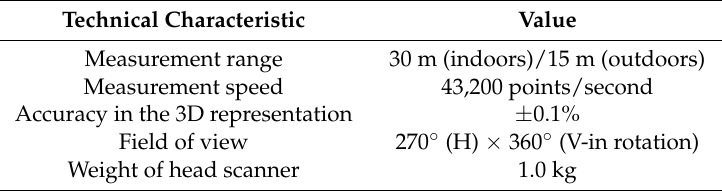
Figure 6. View of the Zeb-Revo during acquisition. Table 2. Technical characteristics of the Zeb-Revo portable mobile mapping system provided by the manufacturer.